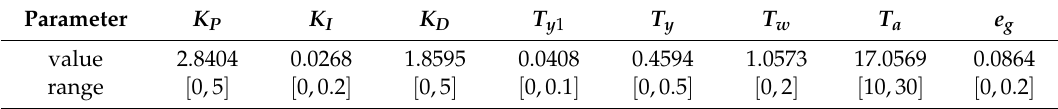
Table 3. Actual value and initial range of the parameters to be identified (no-load condition).